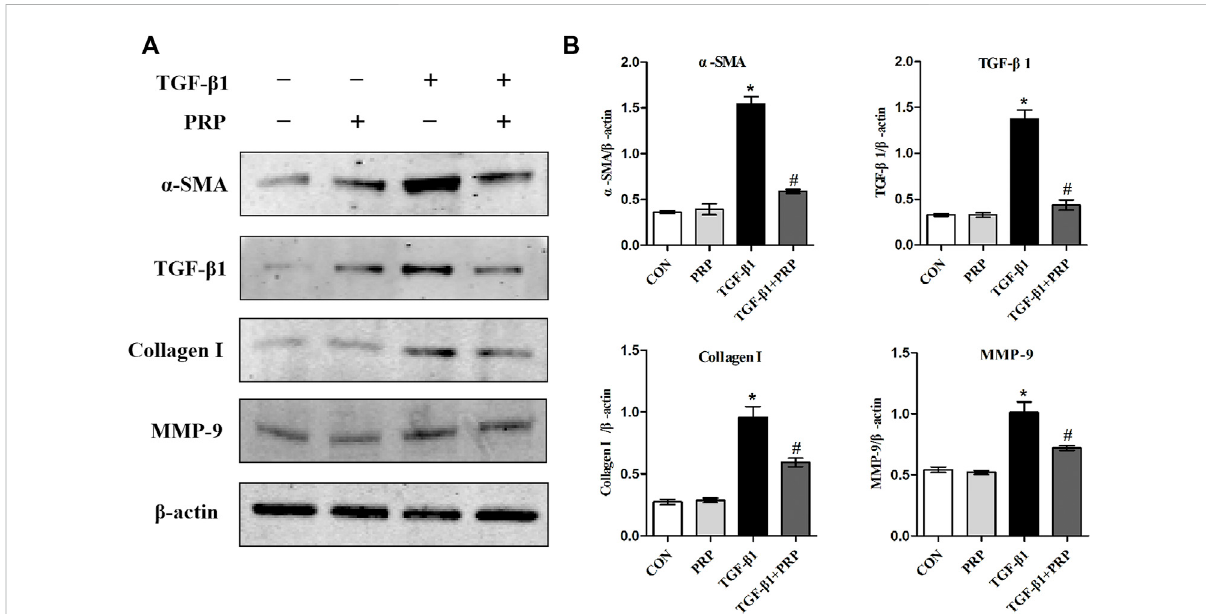
FIGURE 2 Effects of PRP on the protein expression of TGF- β 1-induced fi brotic marker. (A) Western blot analysis of fi brosis-associated proteins α -SMA, TGF- β 1, COL- Ⅰ , MMP-9 after fi broblasts treated with 10 ng/ml TGF- β 1 combined with PRP. (B) The bar graphs represent the relative expression of theseproteinsafter normalizationto β -actin.Errorbarsrepresentstandarddeviation. * p < 0.05comparedwiththeCONgroup.# p < 0.05compared with TGF- β 1